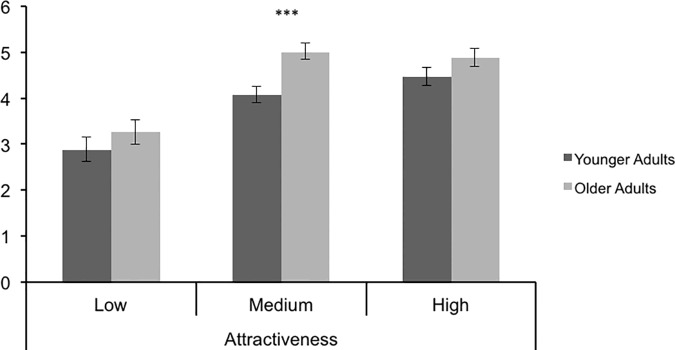
Trustworthy ratings by Face Valence and Rater Age in Study 1.